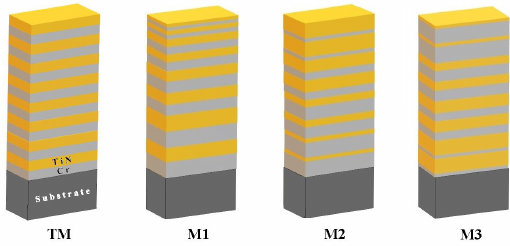
Figure 2. Schematic representation of multilayers